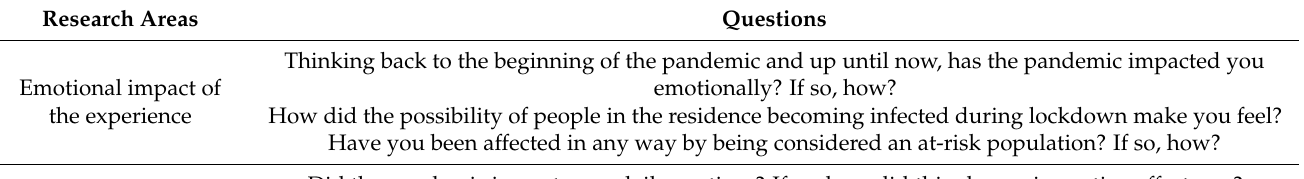
Table 1. Semi-structured interview question